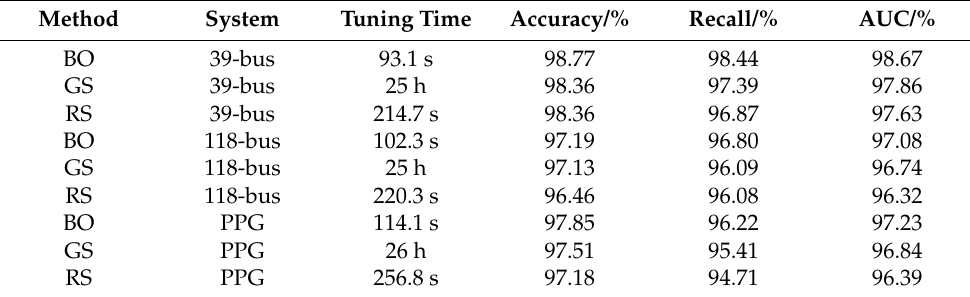
Figure 3. ( a ) Distribution of Accuracy impacted by learning rate and l2_leaf_reg; ( b ) distribution of Recall impacted by learning rate and l2_leaf_reg; ( c ) distribution of AUC impacted by learning rate and l2_leaf_reg; ( d ) distribution of AUC impacted by learning rate and n_ estimators. Table 2. Performance comparison of different parameter tuning